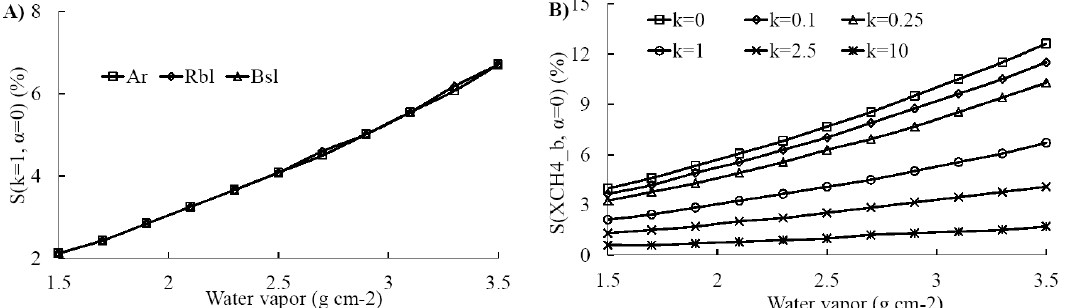
Figure 12. S (XCH 4_b , α = 0 ) resulting from an overestimation of 9% in water vapor for ( A ) three pixels types, Asphalt road (Ar), Brown sandy loam (Bsl), and Reddish-brown sandy loam (Rbl) with the XCH 4 plume case, defined as k = 1, and ( B ) the pixel Ar for different XCH 4 plume strengths k = 0, 0.1, 0.25, 1, 2.5, 10. k = 0 represents background.